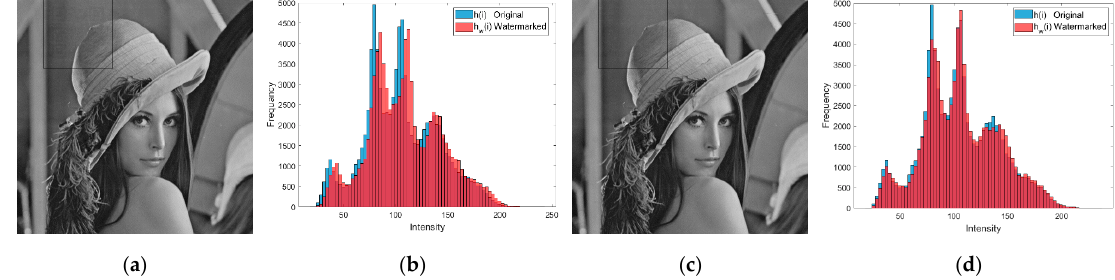
Figure 5. Histogram distortion and visual degradation, ( a ) watermarked image by original watermark, ( b ) histogram of ( a ), ( c ) watermarked image by complement watermark, ( d ) histogram of ( c ). According to the proposed strategy, an embedding error ( EE ) measurement is ob- tained; it considers all the pixels in the ranges (0 , µ R -1) and (µ R , 255) where the ‘0s’ and ‘1s’ of the watermark were embedded, respectively, as given by (15).